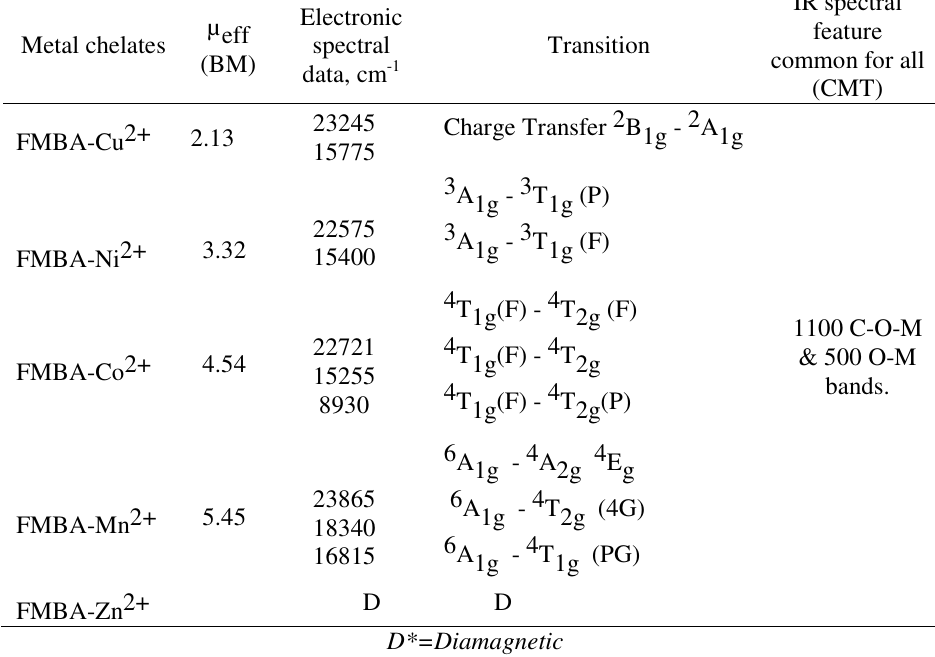
Transition Charge Transfer 2 B 1g - 2 A 1g 3 A 3 T 1g - 1g (P) 3 A 3 T 1g - 1g (F)